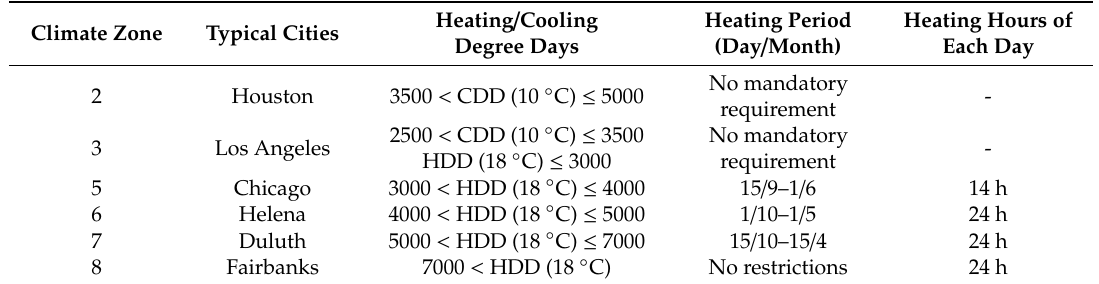
Table 1. Heating period in US typical cities [21].